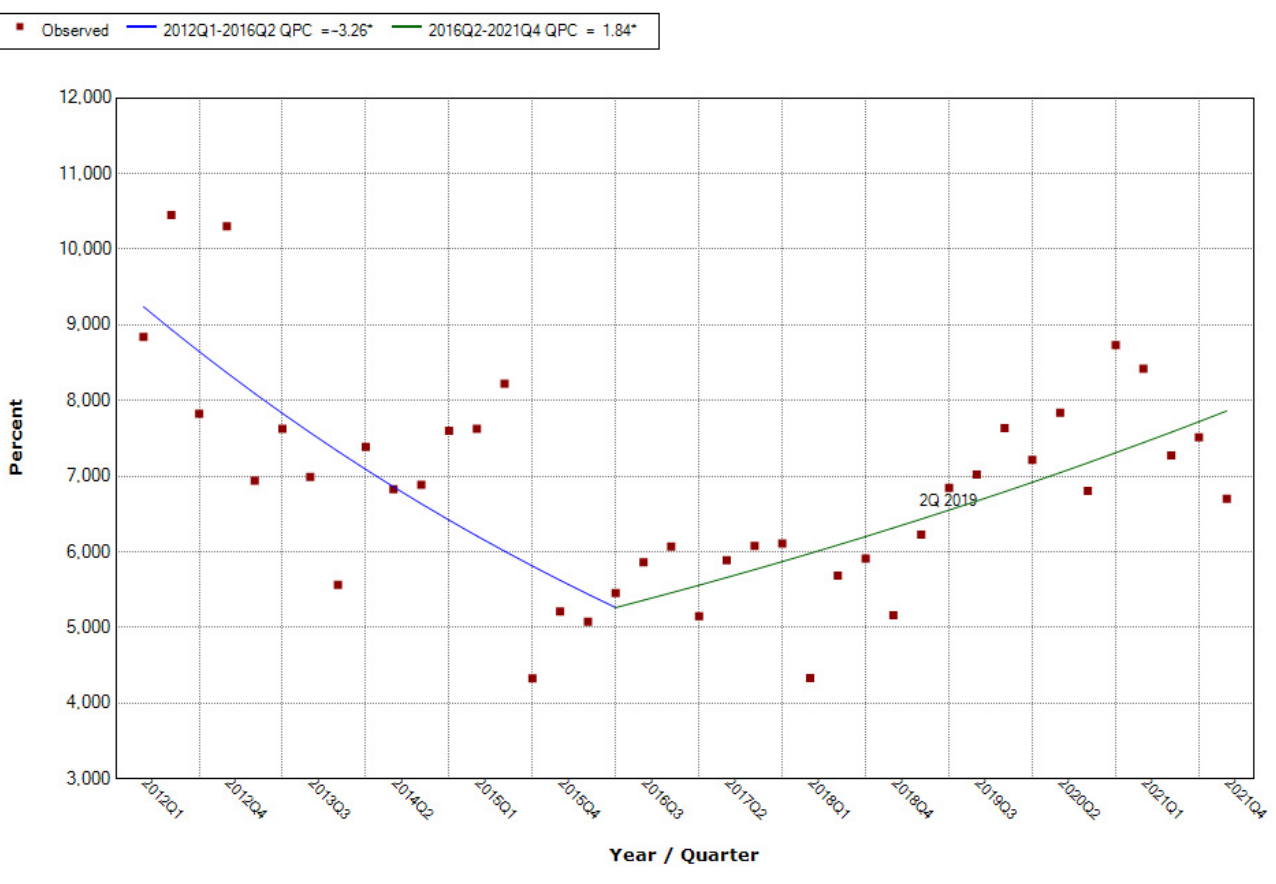
Figure A23. Percentage of products containing vitamin A in individual quarters in the period from 2012 to 28 November 2021. Joinpoints mark trend turning points. The date above the observation indicates the moment of publication of the scientific opinion/resolution.